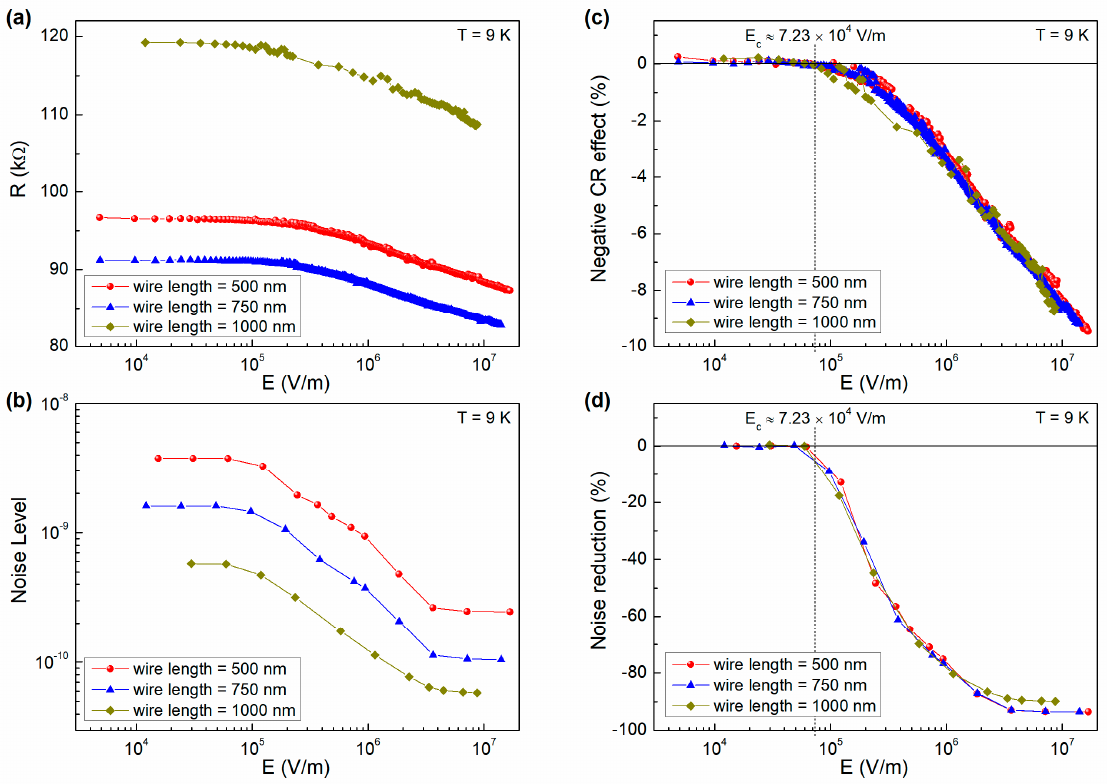
Figure 8. Electric field behavior of DC and AC data at 9 K. For the nanowires 500 nm-long (red circles), 750 nm-long (blue triangles), and 1000 nm-long (yellow diamonds), it is shown the electric field dependence of the: ( a ) static resistance, ( b ) noise level evaluated with Equation (1), ( c ) current-resistance effect evaluated with Equation (2), and ( d ) noise reduction evaluated with Equation (3).